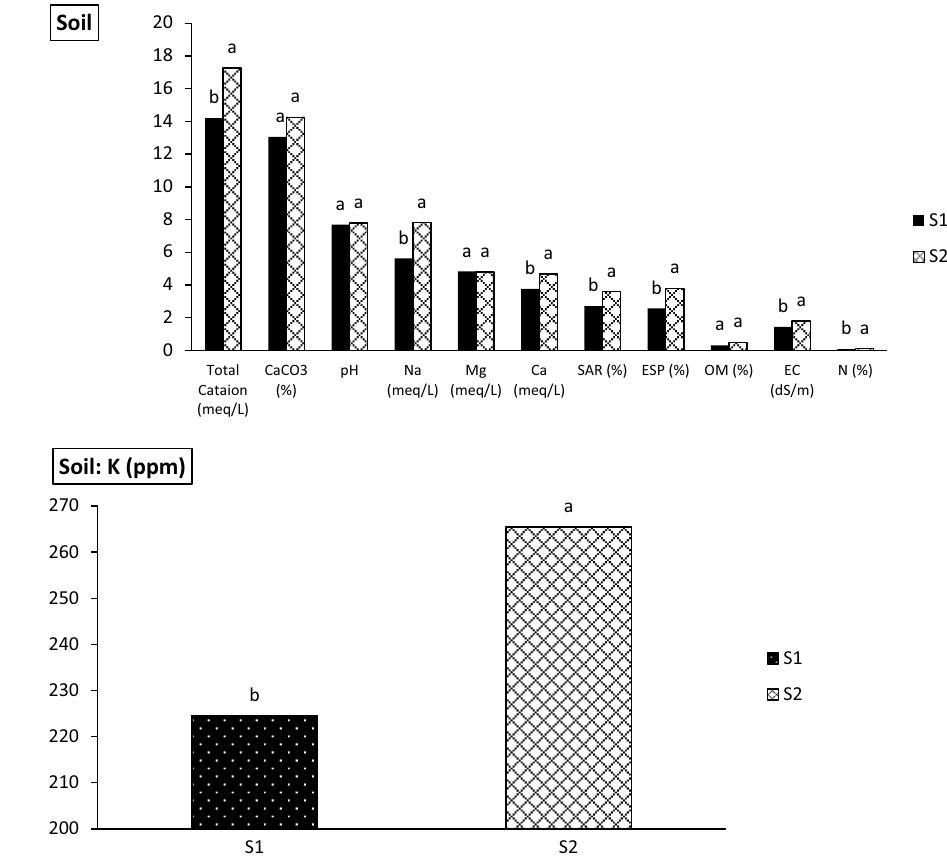
Fig. 7 Effect of volcanic tuff on nutrient contents of